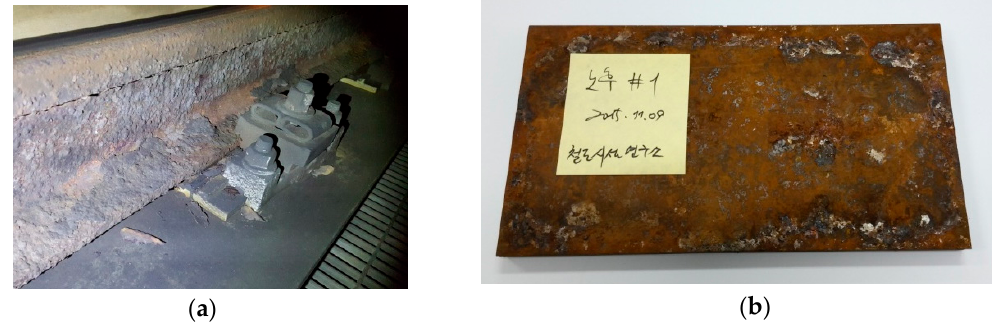
Figure 2. Photographs of corroded rail and pad. ( a ) Corroded track components and ( b ) corroded rail pad.